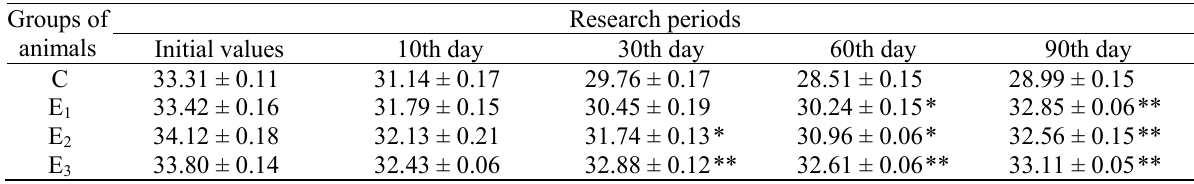
The effect of methionine, phenarone and methyphene on the serum activity of superoxide dismutase in piglets under chronic nitrate- nitrite toxicosis SU/mg of protein, (М ± m, n = 5) Groups of